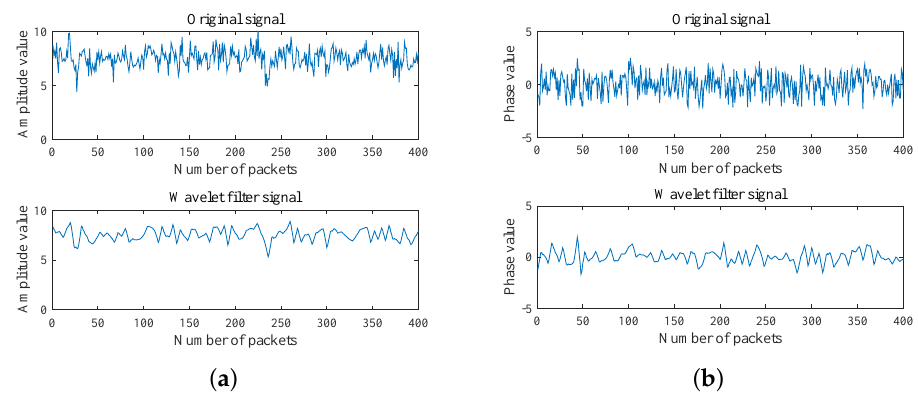
Figure 2. Comparison between the original and the filtered signal. ( a ) amplitude; ( b )